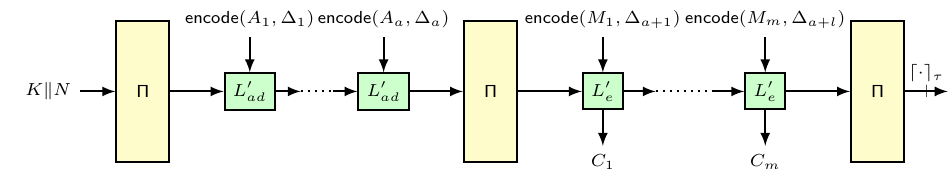
Figure 2: Schematic of the Transform-then-Permute AEAD mode. Here we assume | N | = b − κ , ( Y, A ) = L ( Y ) ⊕ A . L functions and ∆ values are as described 0 L 0 ad ad , L e , encode ad